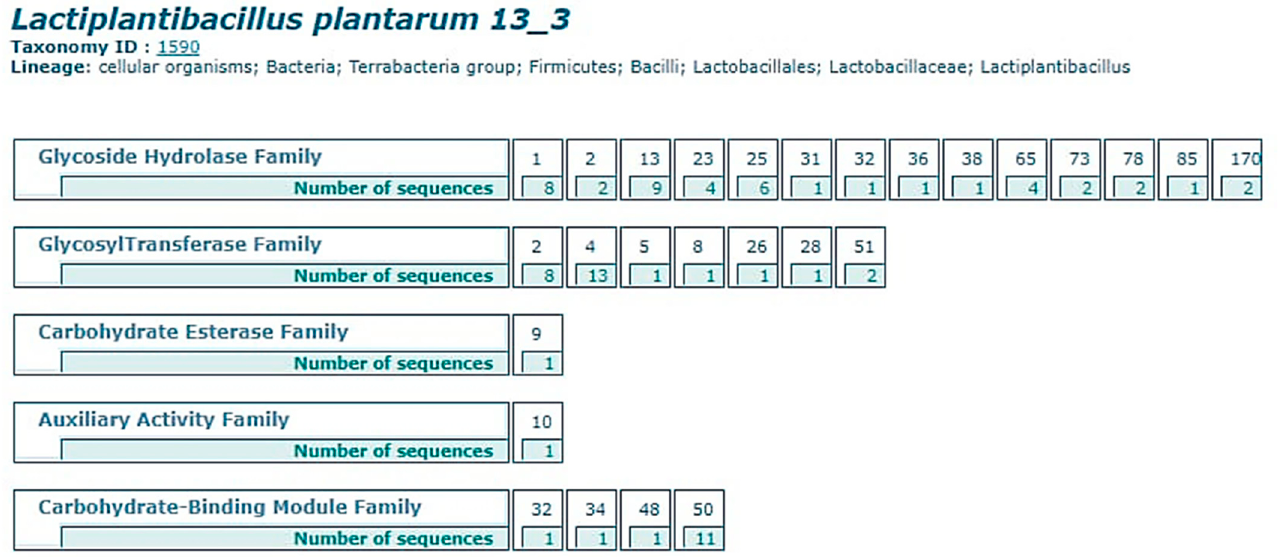
Figure 5. Carbohydrate ‐ active enzymes prediction by CAZy database showing the prediction of the glycoside Hydrolase family, glycosyltransferase family, carbohydrate esterase family, auxiliary esterase family and carbohydrate binding module family.